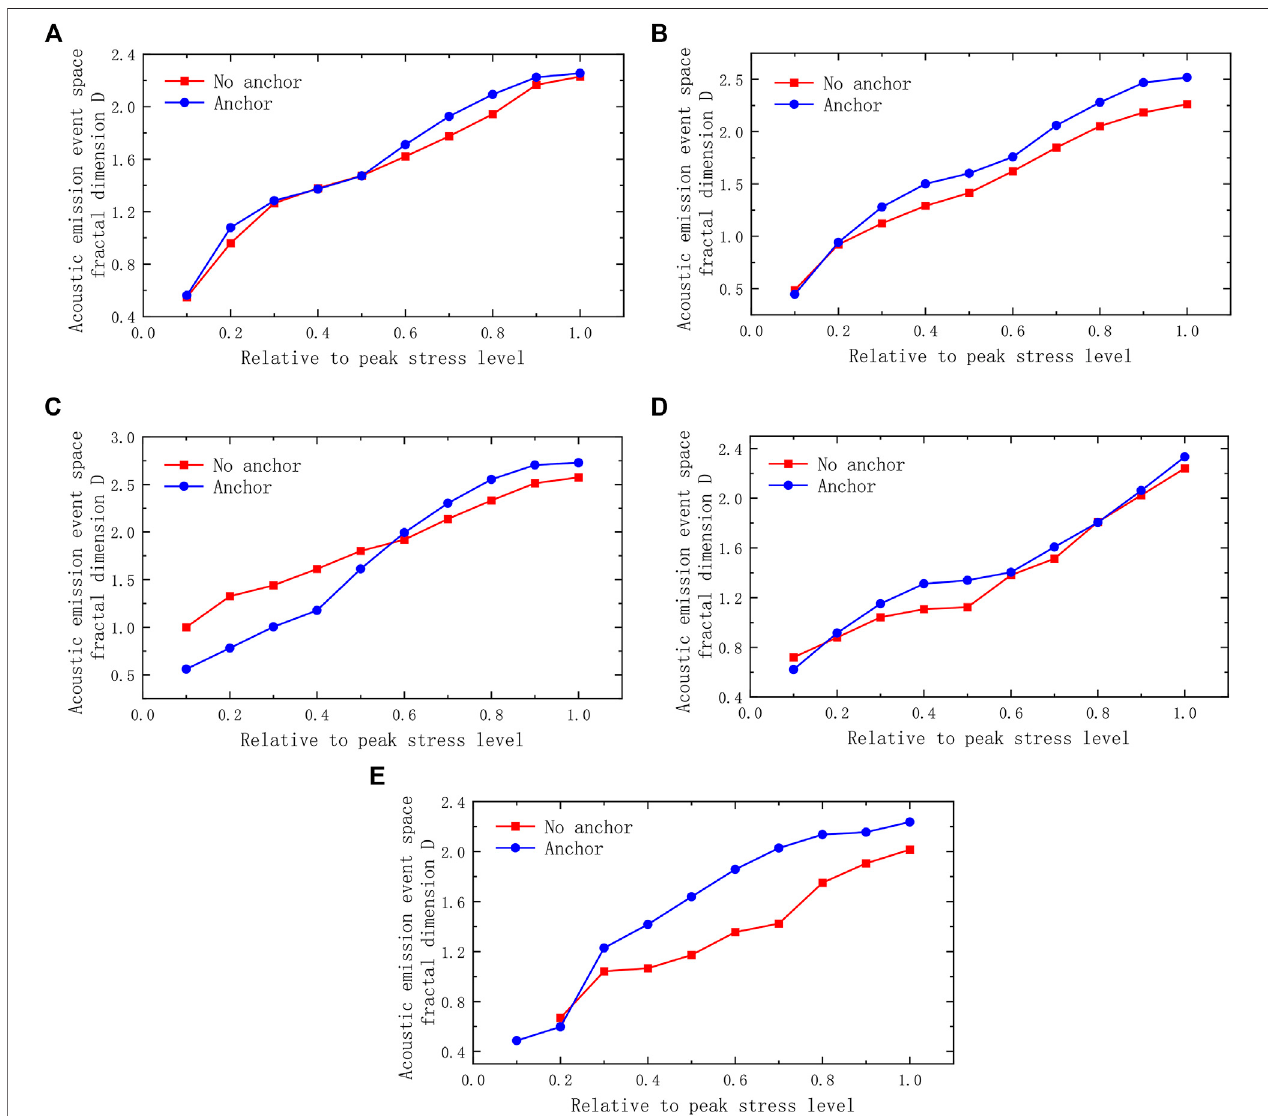
FIGURE 15 | Relationship between acoustic emission event spatial fractal dimension and stress: (A) 0 ° sandstone; (B) 30 ° sandstone; (C) 45 ° sandstone; (D) 60 ° sandstone; (E) 90 ° sandstone.